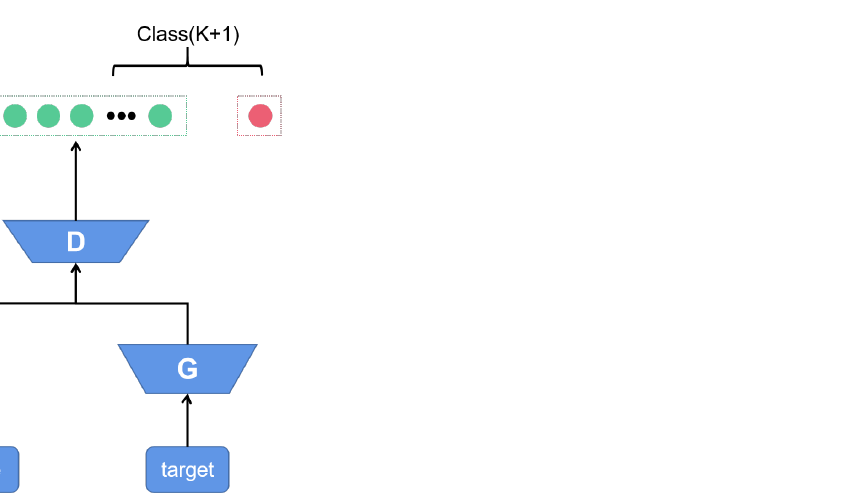
Figure 5. Multi-label GAN. When training discriminator, the Source data is divided into K categories, and the target data is classified as the K+1. And, for the generator, the target is classified into one of the K categories.